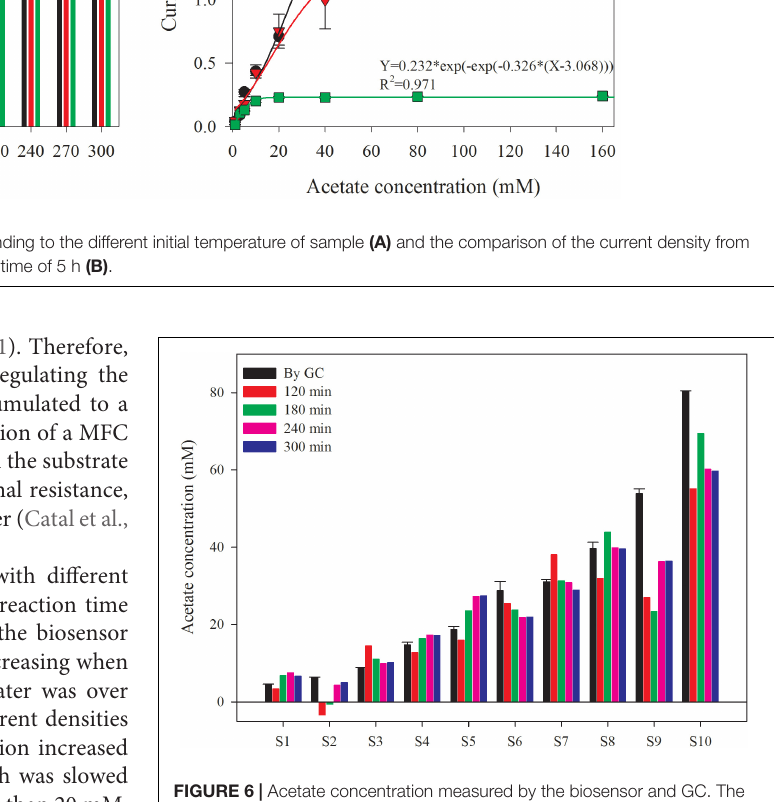
FIGURE 6 | Acetate concentration measured by the biosensor and GC. The sample was 5 times diluted AD effluent from a CSTR reactor fed with cow manure mixed with different acetate